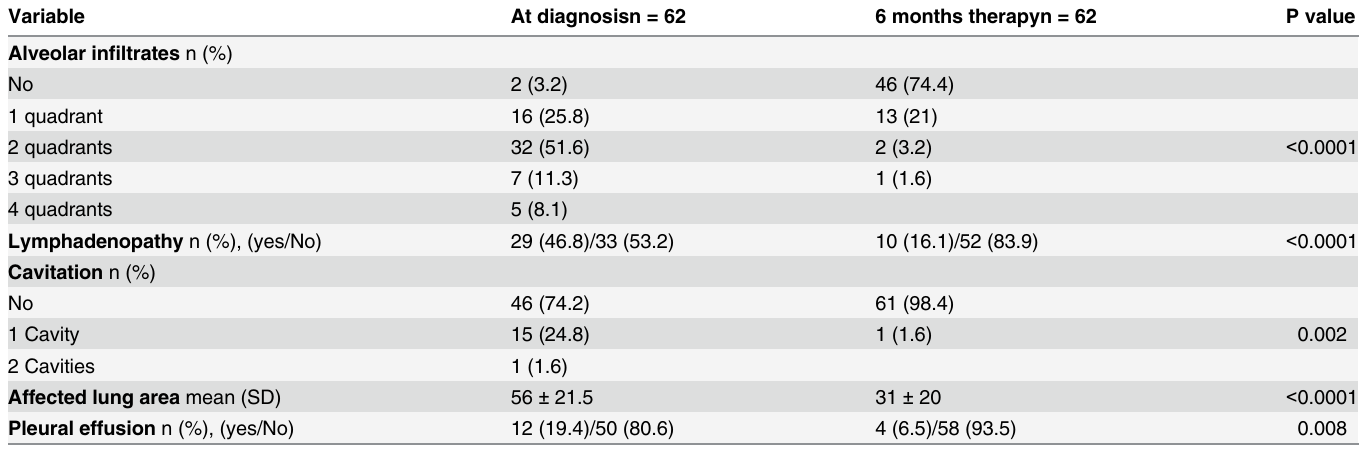
Table 8. Changes in CXR specific features at diagnosis and after 6 months of DOTS